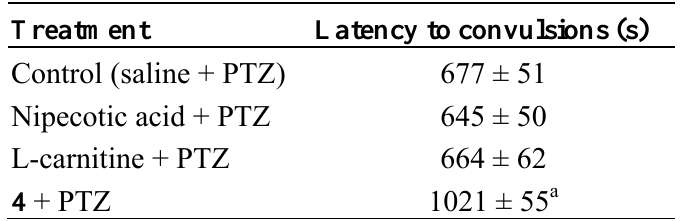
Table 1. Effect of ip injection of nipecotic acid (0.75 mmol/kg), L-C (0.75 mmol/Kg) or